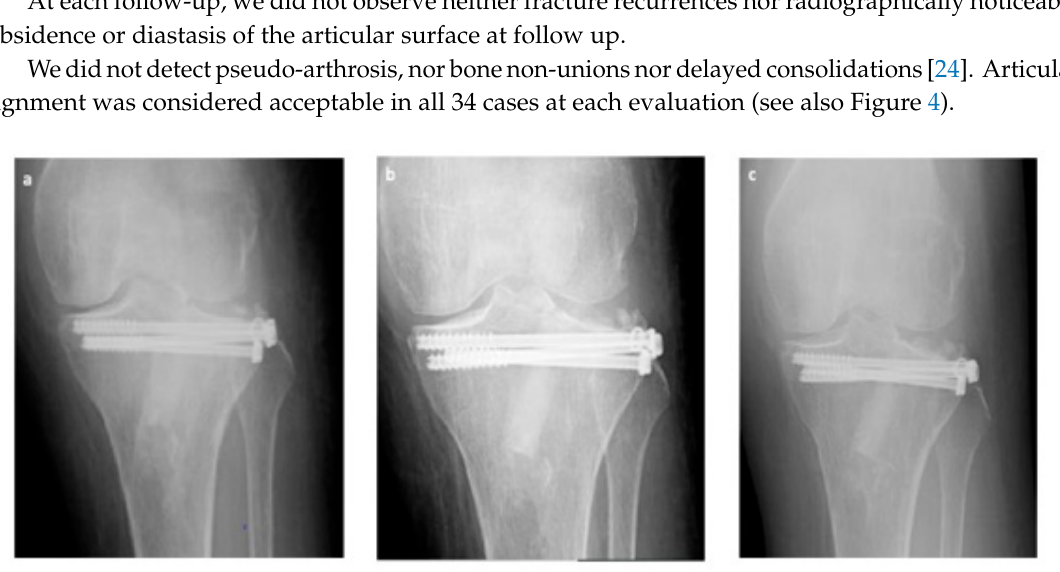
Figure 4. Exemplificative case, in anteroposterior RX, at 1 ( a ), 3 ( b ), and 6 ( c ) months follow-up respectively, well evidencing good consolidation, absence of non-union or retarded consolidation and graft good integration confirmed by progressive loss of radiolucency of the graft itself.